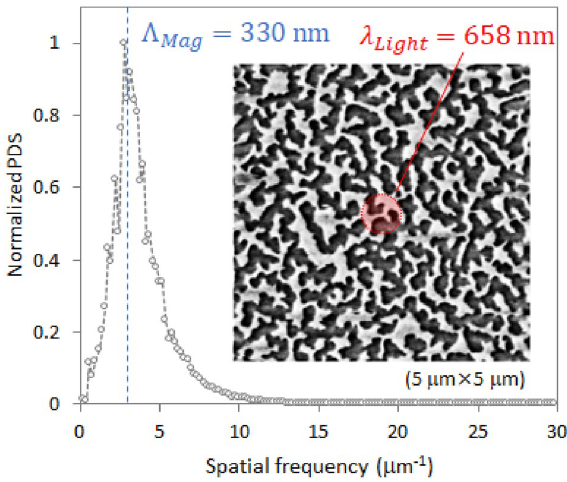
Figure 5. 2D-PSD plot calculated from the 2D fast Fourier transform of the MFM image of the MO–SPR sample in the dc-demagnetized state. The red circle shows the size of the wavelength of the measurement